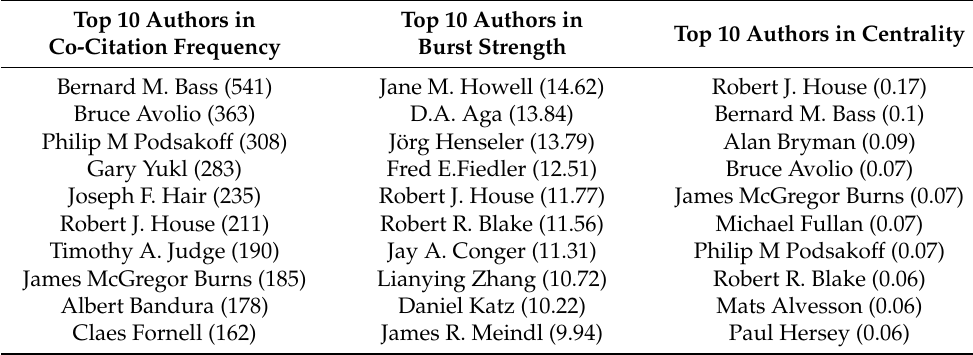
Figure 7. Author co-citation network. Table 4. Top 10 authors in terms of co-citation frequency, burst strength and